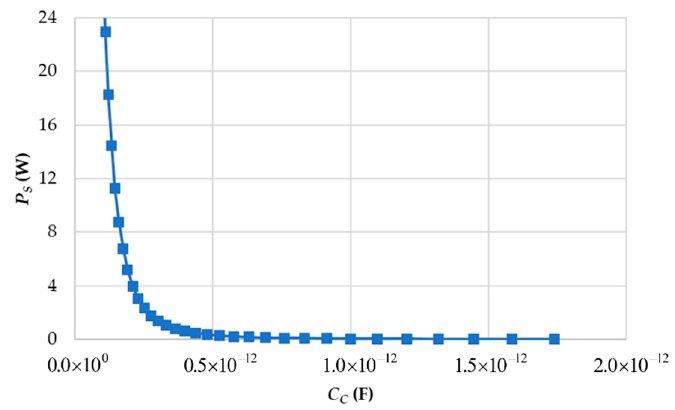
Figure 12. Inductance power loss as a function of coupling capacitance.